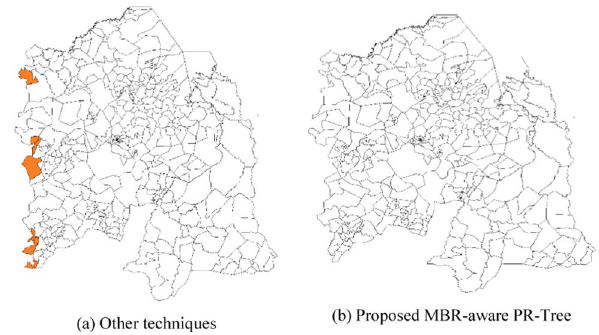
Fig. 12 Range query with a random query window area 0.00005% of Cities dataset